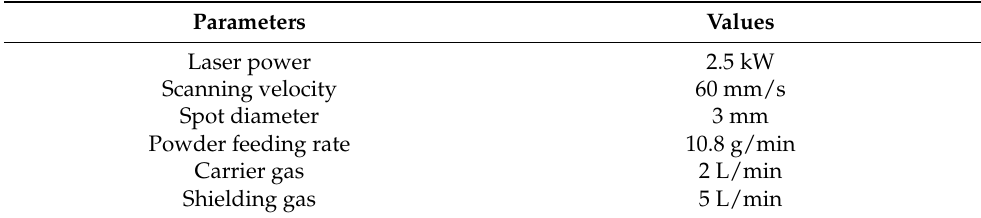
Table 2. Adopted parameters of the LMI